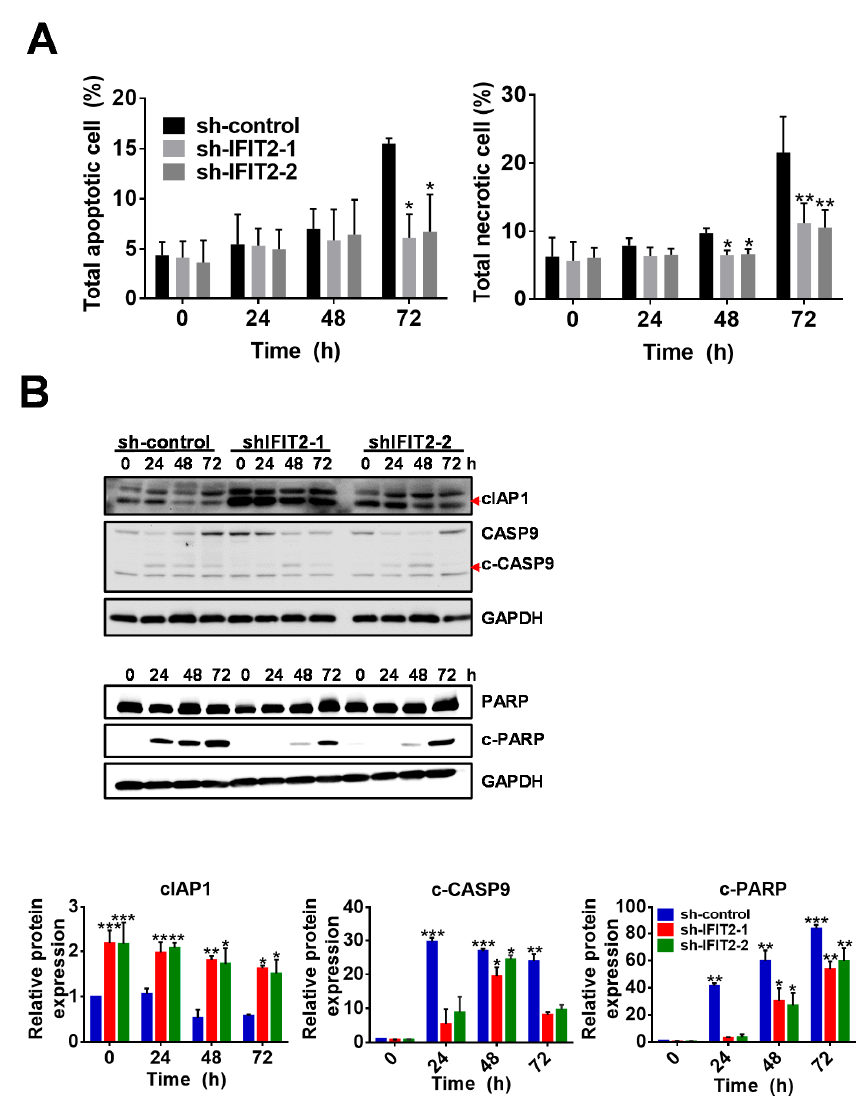
Figure 3. Apoptotic death triggered by 5-FU. ( A ) Quantitative data analysis of apoptotic cell death. Data are presented as the mean ± SEM of three independent experiments. * p < 0.05 and ** p <